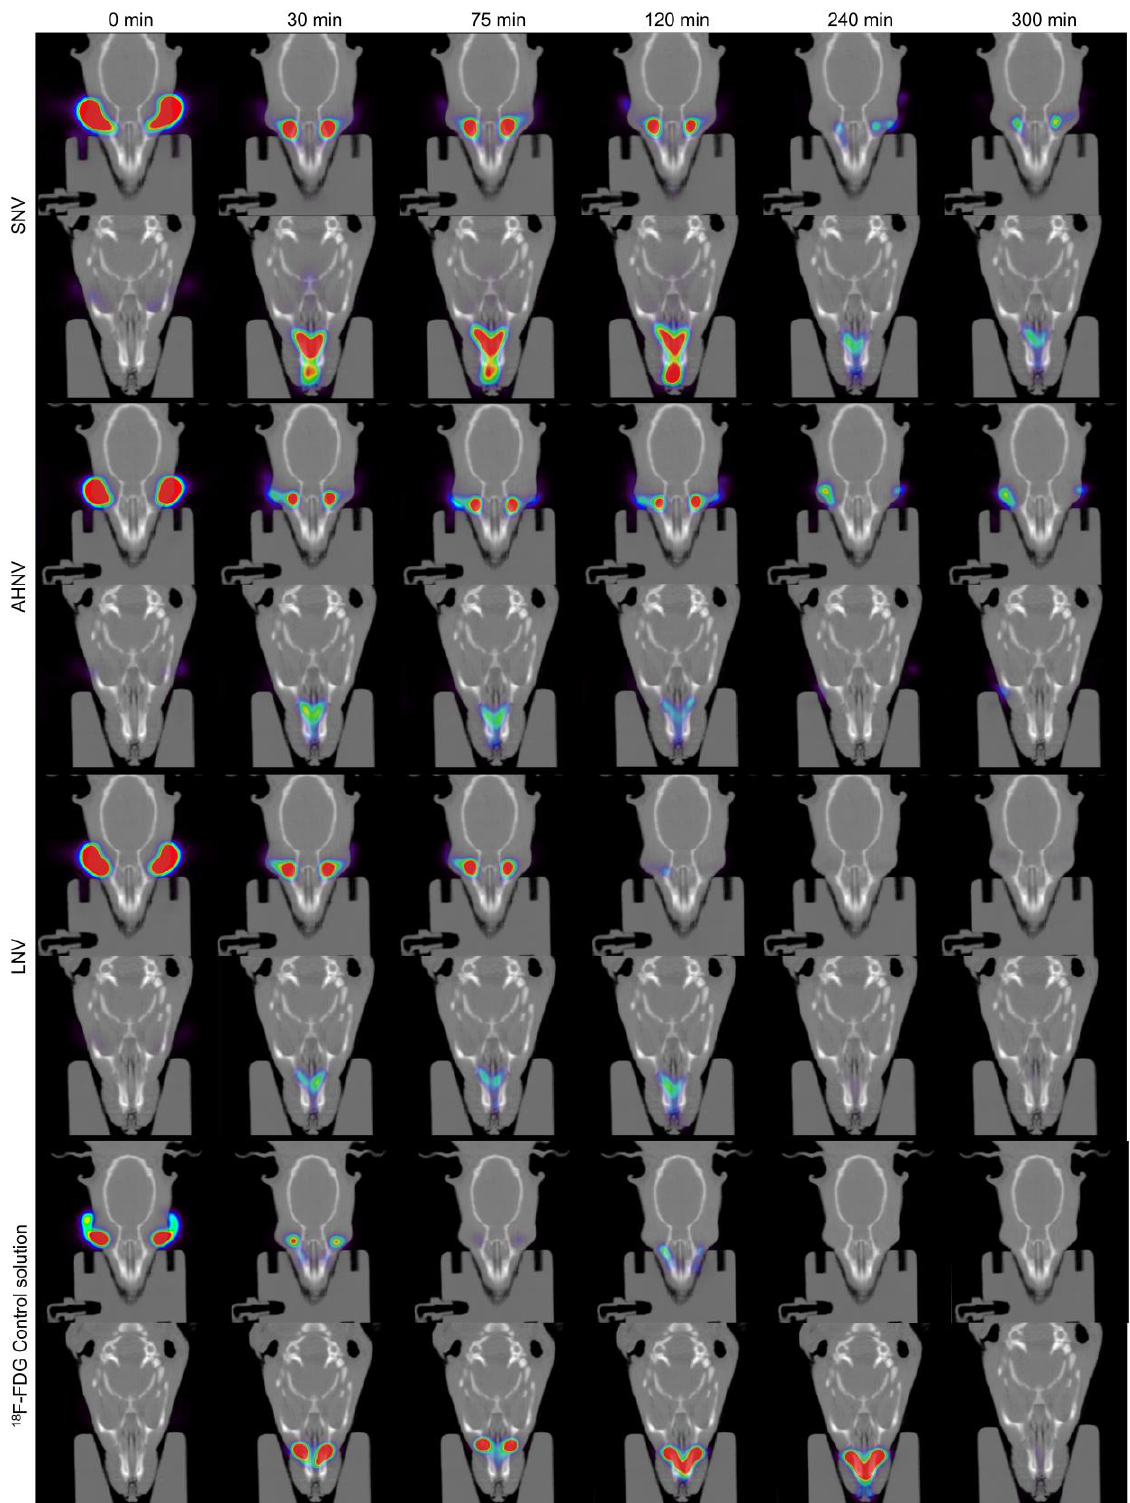
Figure 13. Coronal PET/CT images of rat eyes treated with SNV, AHNV, and LNV over time. Data were compared with a 18 F-FDG control solution. The amount of formulation on the ocular surface is coded on a color scale: blue areas show a low radioactive activity; red areas show high radioactive activity.